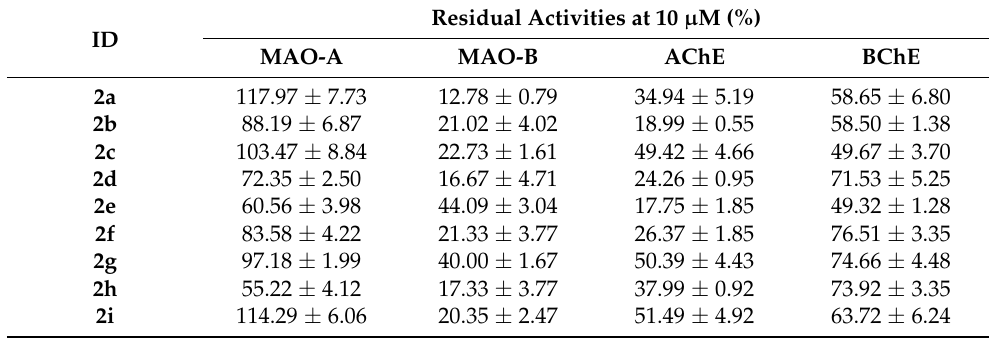
Table 1. Preliminary assay of compounds 2a – q against MAO-A, MAO-B, AChE, and BChE at 10 µ